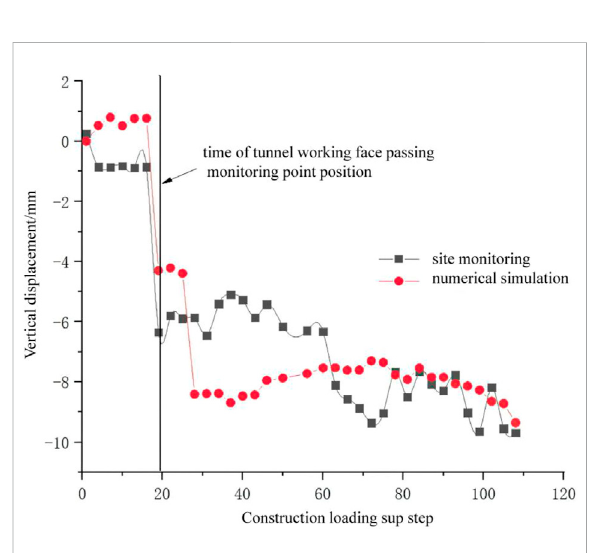
FIGURE 20 Comparisonofsettlementvaluesbetweennumericalanalysis and site monitoring for point